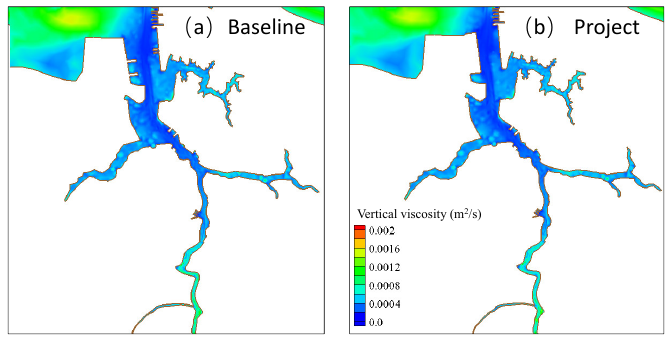
Figure 13. Typical patterns of the depth-averaged eddy viscosity in the Elizabeth River under: ( a ) baseline condition; ( b ) project